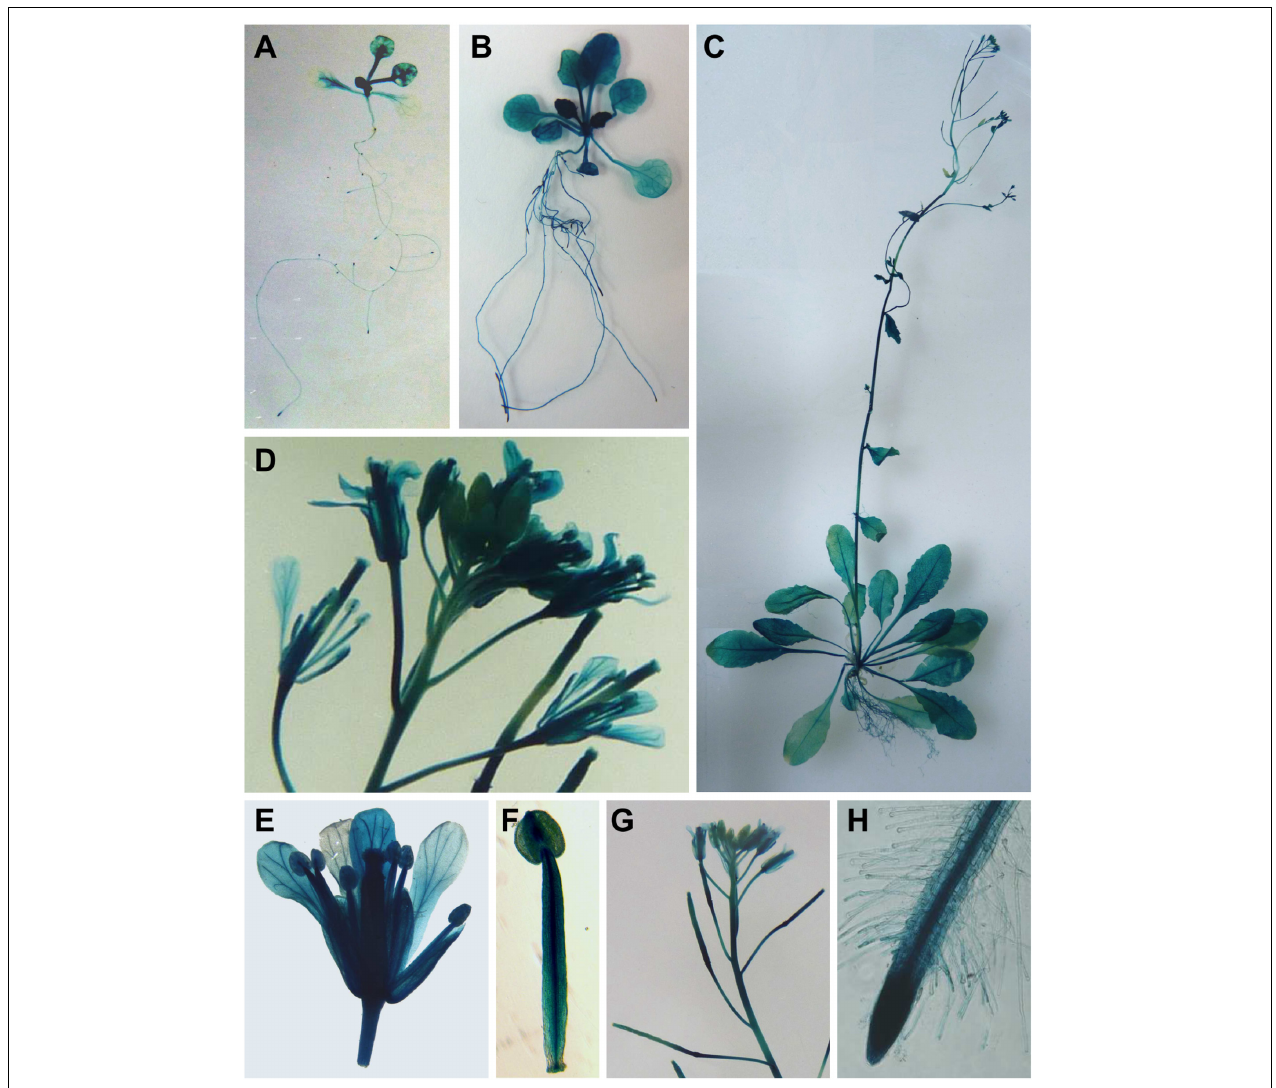
FIGURE 2 | Histochemical GUS staining of plants expressing the U3::GUS construct. (A) A 14-day-old plant. (B) A hydroponically grown 25-day-old plant. (C) A soil-grown plant at the reproductive stage. (D) An inflorescence. (E) A flower. (F) A stamen. (G) Inflorescence and siliques. (H) A root